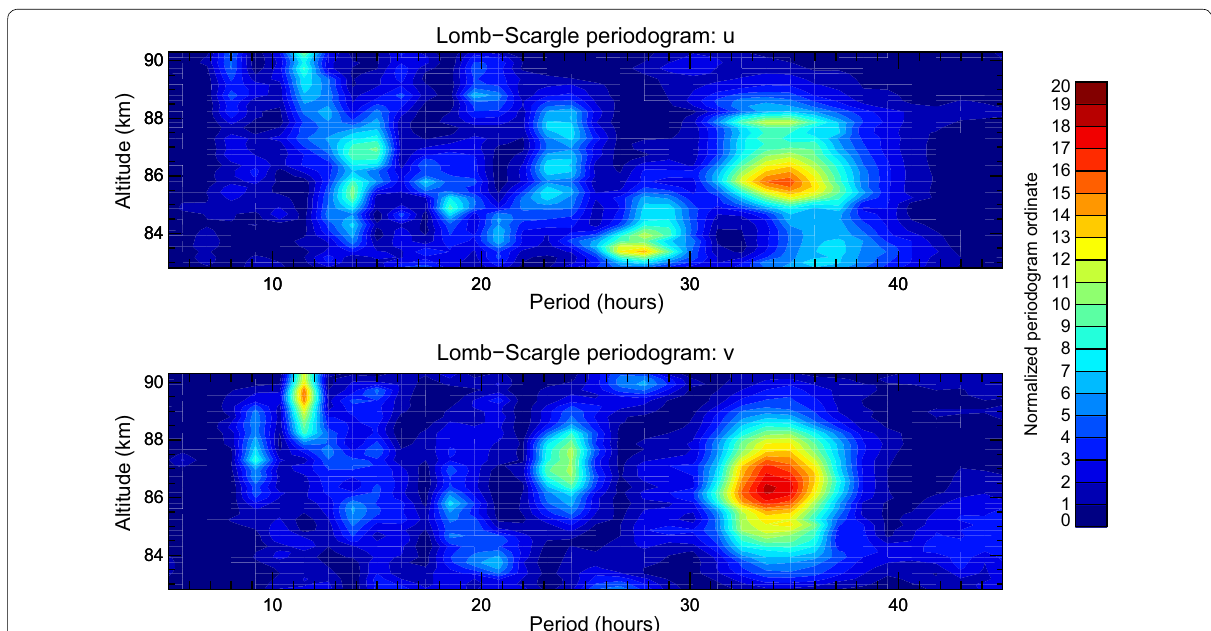
Fig. 6 Lomb periodograms of the zonal (left) and meridional (right) winds for the entire observational period. Pronounced periodicities are evident at 8, 12, and 24 h, and also between 32 and 36